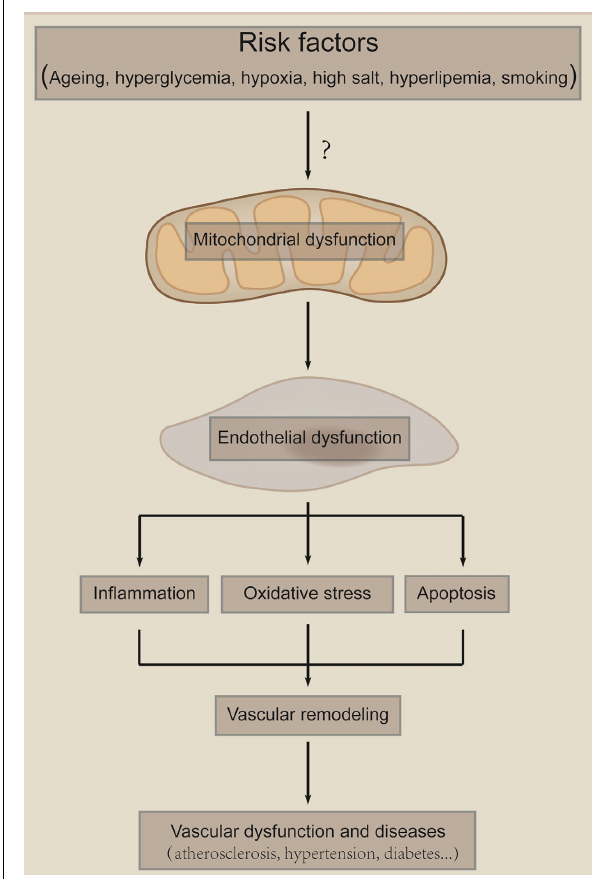
FIGURE 4 | Mitochondria as a sensor of damage signals. Mitochondria serve as a sensor of environmental damage signals, such as hyperglycemia, aging, hypoxia, high salt, and smoking. Those risk factors cause mitochondria damage and subsequent endothelial dysfunction. Endothelial dysfunction leads to inflammation, oxidative stress and cell death, which result in vascular remodeling and subsequent vascular diseases. The “?” means that it is largely unknown how risk factors induce mitochondria